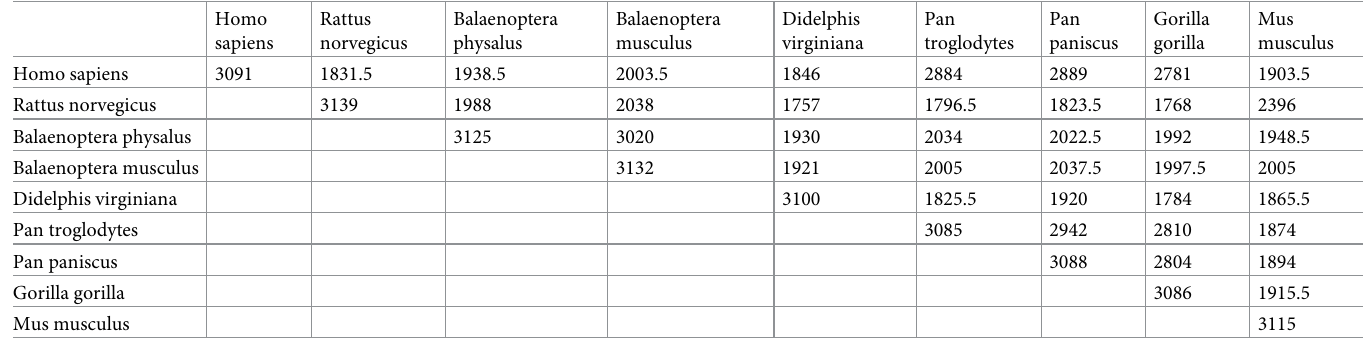
Table 3. The parameter Alignment Score of the HELIOS method in the quantitative measurement of homology. To calculate the Alignment Score of two compared sequences aligned by the HELIOS method, the BLOSUM62 substitution scoring matrix is adopted with gap opening and extension penalties equal to -10 and -0.5, respec- tively. Moreover, the “Nine ND5 protein sequences dataset” [53] is assumed in this study. Homo sapiens